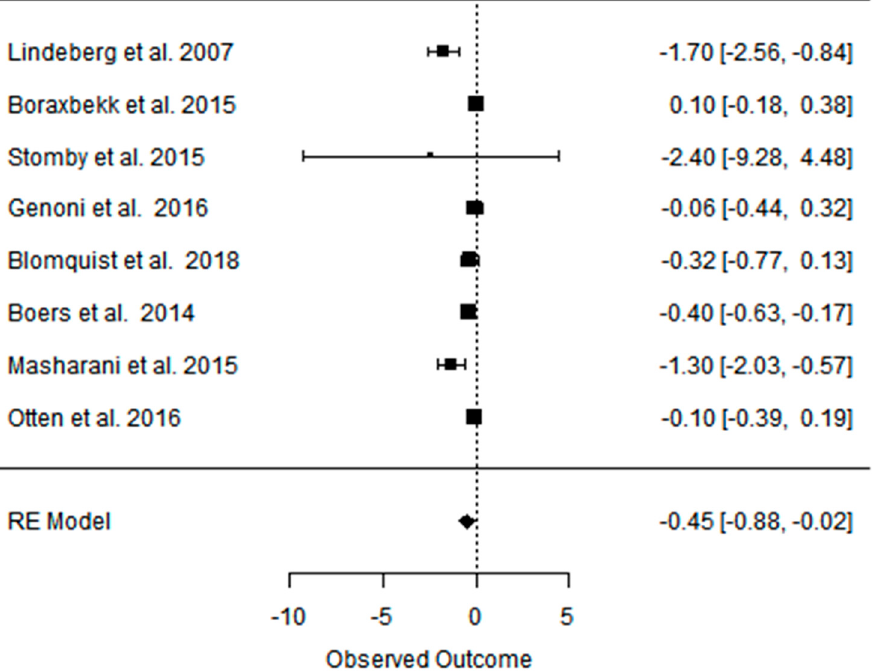
Figure A45. Forest plot of the effect of PD on fP glucose (mmol/L) in the short term (weighted mean difference).